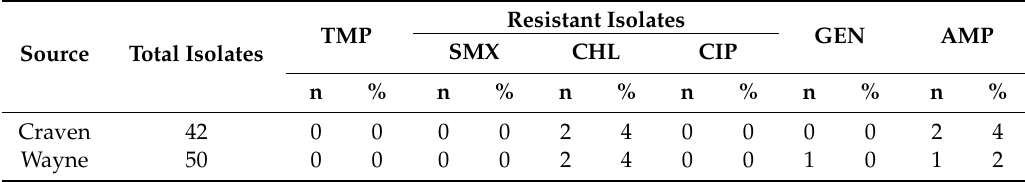
Table 3. Antimicrobial resistance in E. coli isolates from surface